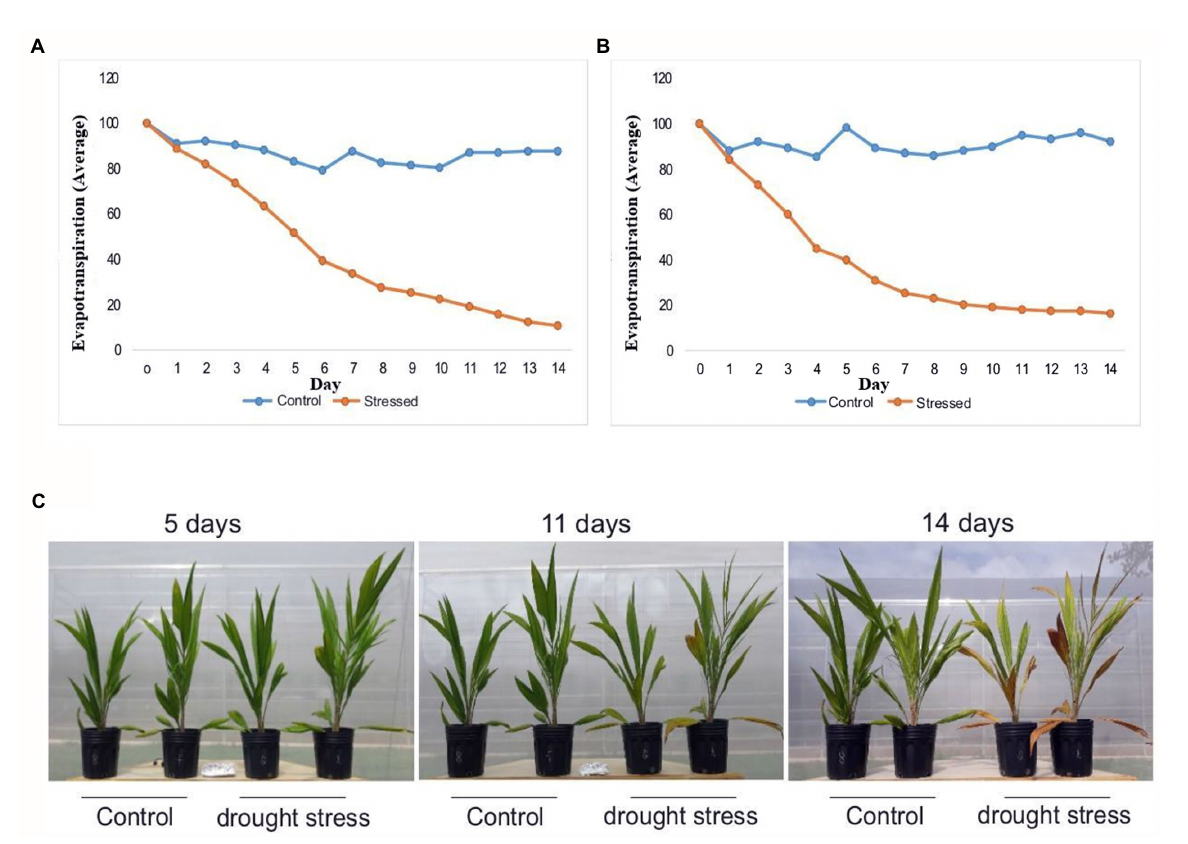
FIGURE 1 Morphophysiological responses of young oil palm plants to drought stress: (A) average daily rate of evapotranspiration of irrigated and non- irrigated oil palm plants from experiment 1, (B) average daily rate of evapotranspiration of irrigated and non-irrigated oil palm plants from experiment 2, (C) morphological changes of oil palm at 5, 11, and 14 days of drought stress. Evapotranspiration (Average): Percentage of the initial value measured in day